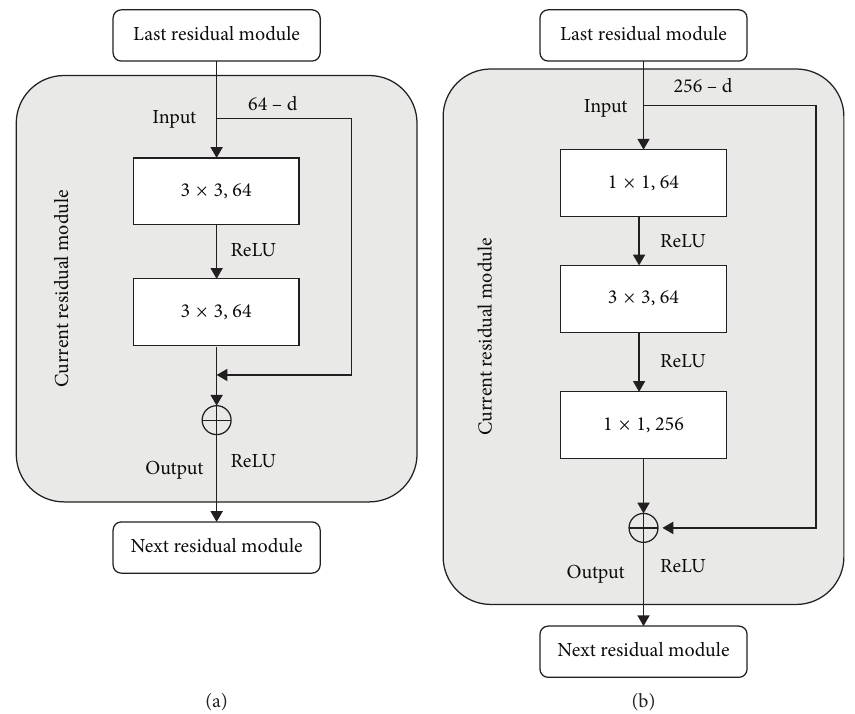
Figure 2: Basic components for residual neural network. (a) ResNet 18/34. (b) ResNet